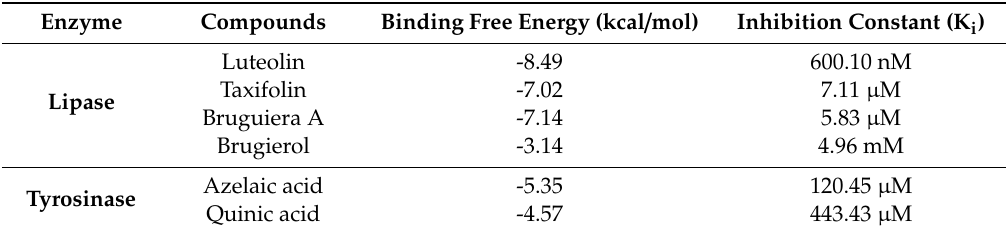
Table 9. Docking free energy and inhibition constants for the docked compounds.